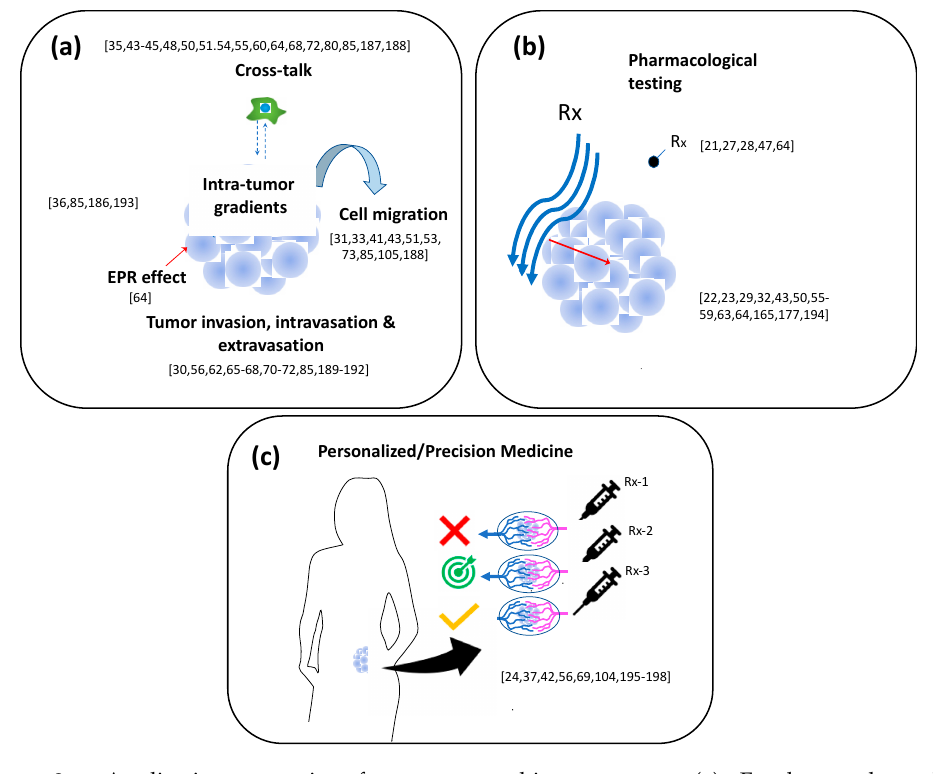
Figure 8. Application scenarios for tumor-on-chip systems. ( a ) Fundamental studies [30,31,33,35,36,41,43–45,48,50,51,53–56,60,62,64–68,70–73,80,85,105,186–193]; ( b ) Pharmacological screening and testing [21–23,27–29,32,43,47,50,55–59,63,64,165,177,194]; and ( c ) personalized/precision medicine strategies [24,37,42,56,69,104,195–198].